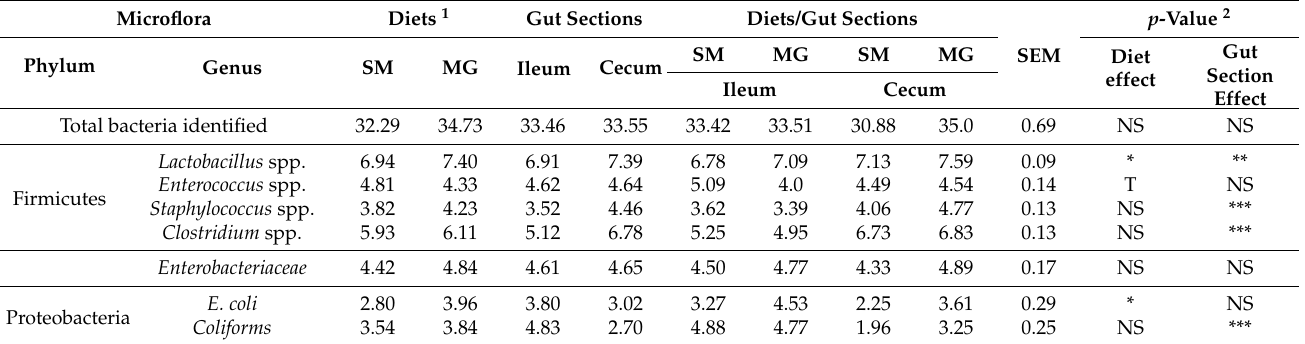
Table 4. Microflora population (log 10 CFU/g) of distal ileum and cecum gut sections from Topigs hybrid pigs (44 ± 3.30 kg) fed a standard level of fiber (SM diet) or a diet based on a high level of fiber (MG